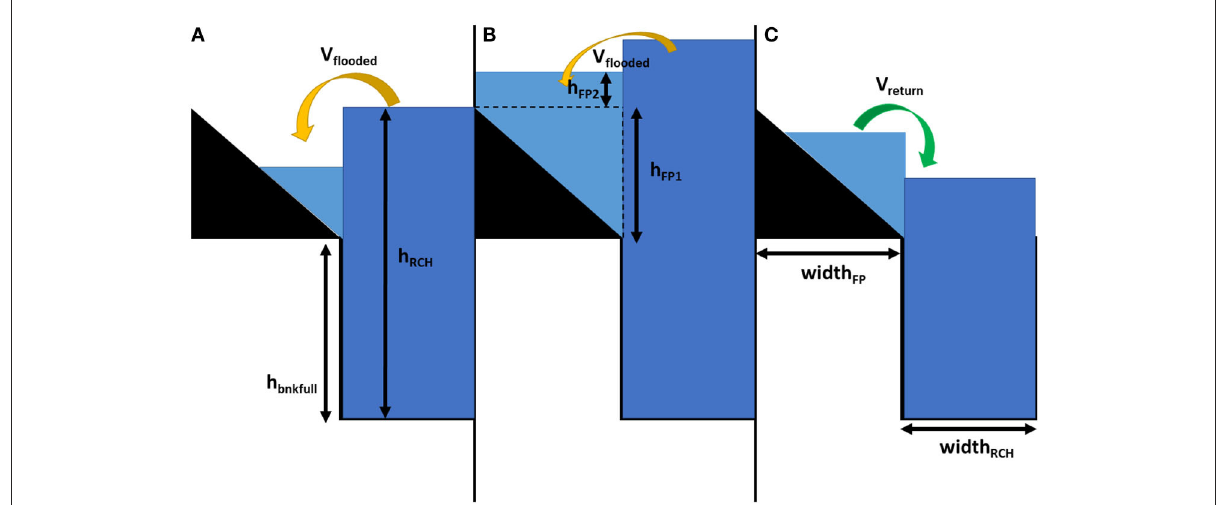
FIGURE2 Simplified representation of the different processes of the overflowing and the return of water in SWAT-FloodPlain. The volume of water entering the floodplain is linked with the water height difference between the floodplain and the stream. h FP is the water height in the floodplain when (A) it is not saturated. In case (B) , the water is stored vertically. (C) The water returns to the stream regarding the height in the stream and the